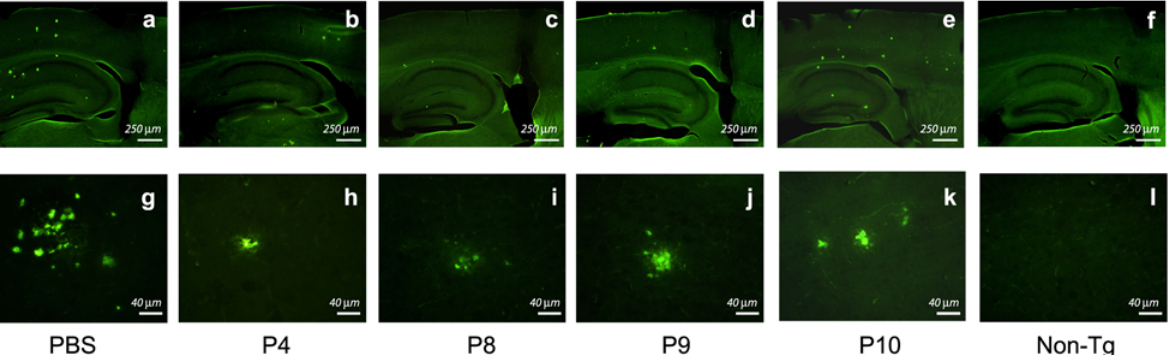
Fig 3. Effects Of Peptides P4 Through P10 Infusion In Brains Of mThy1-hAPP Mice. mThy1-hAPP mice were infused with either PBS or peptides for two weeks, followed by two weeks of rest, using osmotic minipumps. Fixed brains were vibratomed at 40 μ m, immunolabeled with MAb against A β 1 – 16, followed by FITC-conjugated anti-mouse IgG, and imaged with a scanning confocal microscope. Top Panel: Representative low-power (15x) photomicrographs of vibritome sections (bar, 250 μ m). Bottom panel: High power (400x) photomicrographs of amyloid plaques in top panel (bar, 40 μ m). Peptides P4 (panels b and h) and P8 (panels c and i) produced marked reductions in A β labeling compared to PBS controls (panels a and